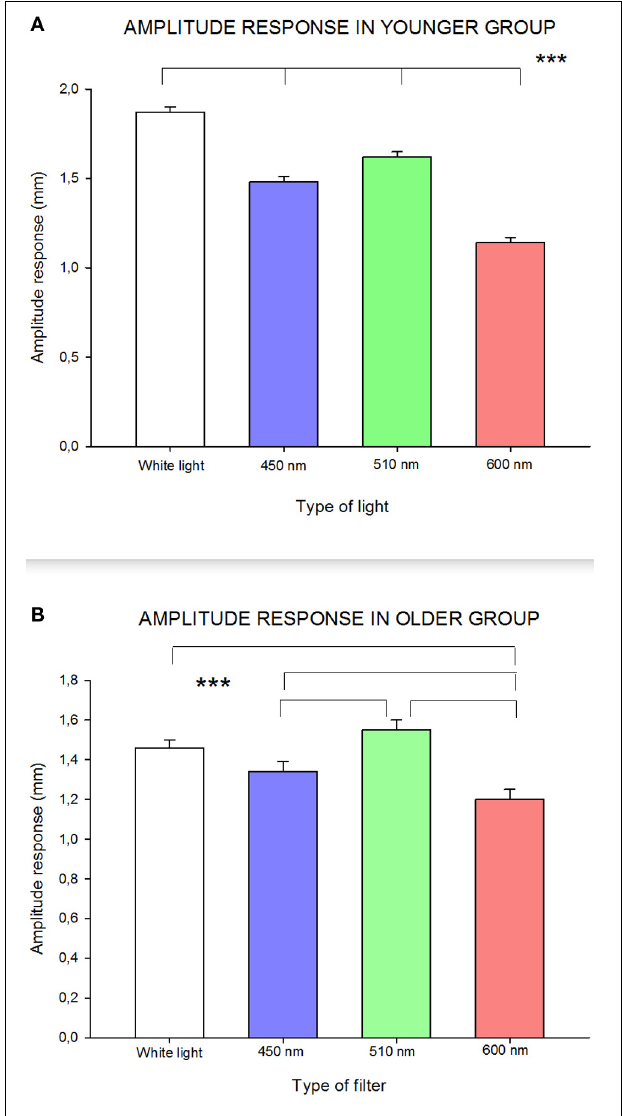
FIGURE 3 | Influence of wavelength on amplitude of response in (A) younger group; and (B) older group. Statistically significant differences are highlighted by the three asterisks ( p -value < 0.001) in both figures. Standard errors are shown with error bars.